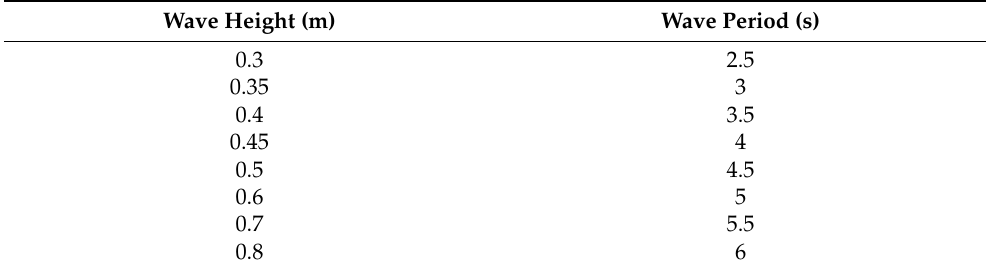
Table 4. Sea states for numerical simulation.